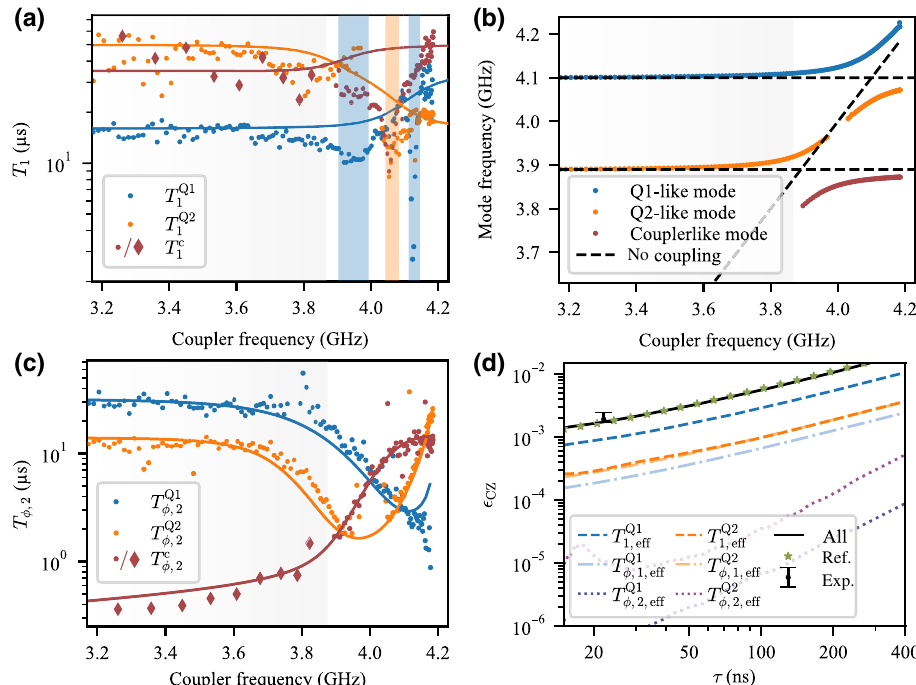
FIG. 4. The impact of the coupler decoherence on the qubits. (a) The energy-relaxation times of the hybridized qubit-coupler modes measured directly (dots), measured via an ancilla qubit (diamonds), and evaluated numerically based on the hybridization with the coupler (solid lines) as a function of the coupler frequency ω c / 2 π . The shaded areas indicate the coupler frequencies swept during the CZ gate (gray) and regions with unknown sources of decoherence, partly attributed to parasitic two-level systems (orange and blue , respectively). (b) The measured frequencies of the hybridized modes during coherence measurements (dense set shading for Q 1 and Q 2 of dots) and the frequencies of the uncoupled system (black dashed lines). (c) The same as in (a) but showing the Gaussian component of the pure dephasing time for the hybridized qubit and coupler modes. (d) The coherence limit of the CZ gate (solid black line) as a function of the interaction time τ , calculated using Eq. (3), with contributions from individual coherence times (dashed lines), and the coherence limit for no decoherence contributions from the coupler (green stars). When evaluating the gate error, an idling time of 11 ns is added on top of the interaction time. The black dot shows the experimental gate error with the 68% confidence interval. The data are below the curve corresponding to T Q 2 and not clearly visible in the for T Q 2 φ ,1,eff 1,eff